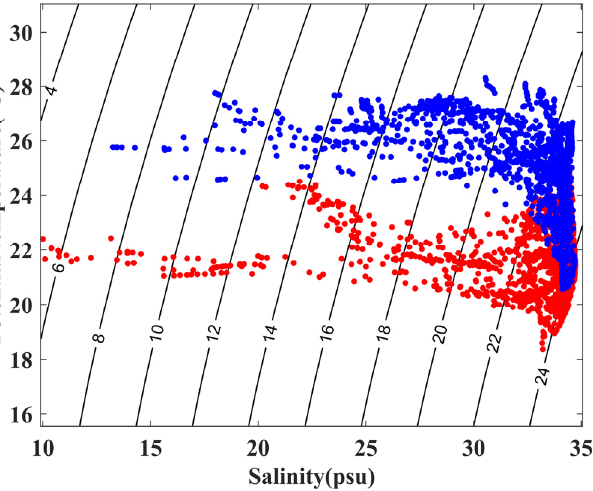
Figure 2. T–S diagram for the two cruise measurements. Red (blue) dots represent April (May) observations. The contours denote the isopycnals (kg/m 3 ).